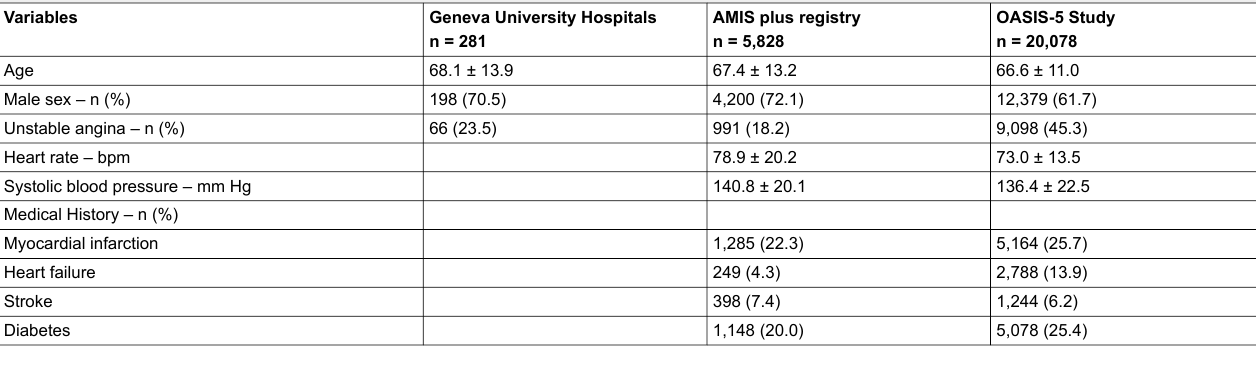
Table 1: Characteristics of the patients in the three populations. Variables